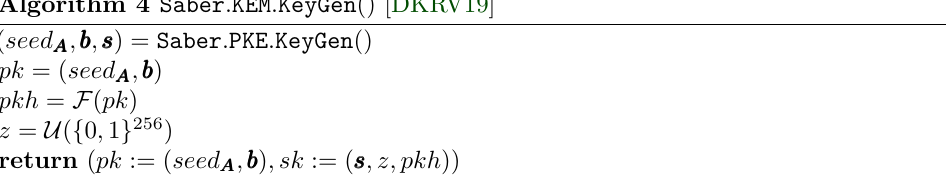
Algorithm 4 Saber . KEM . KeyGen ()